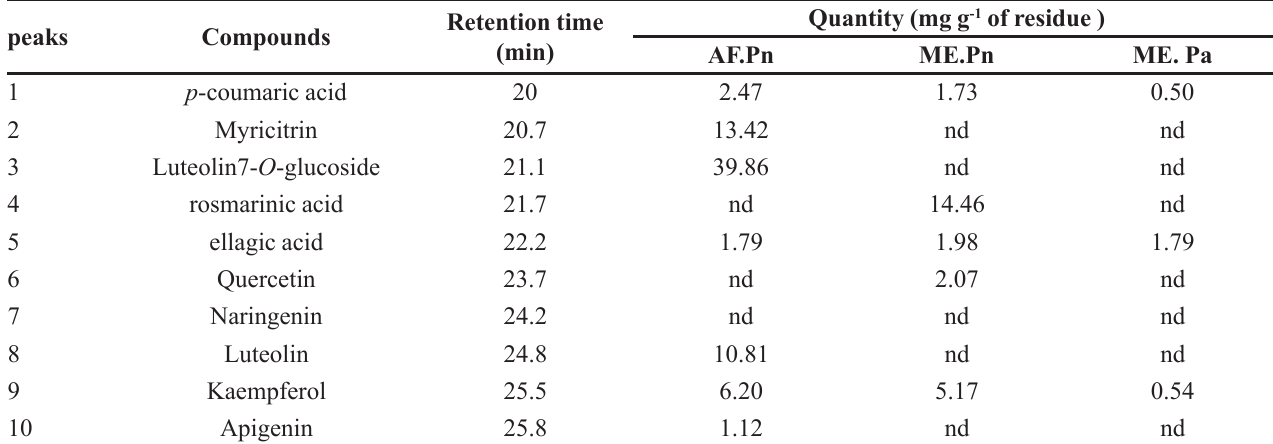
TABLE I - Identification of phenolic compounds in P. nigra and P. alba buds extracts peaks Compounds